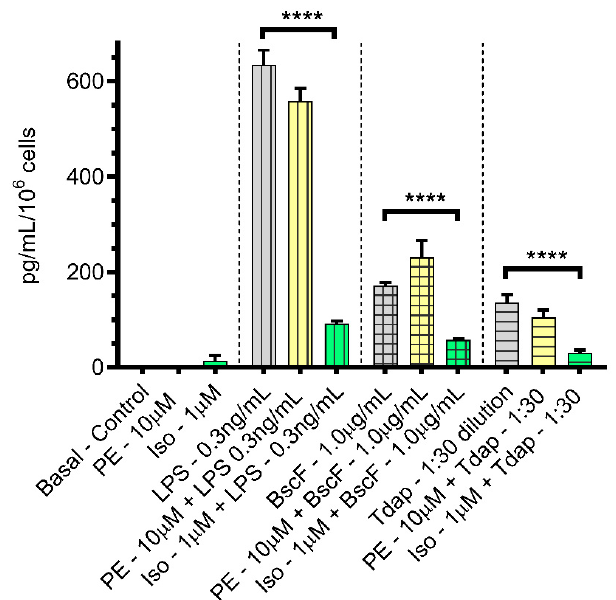
Figure 1. Both PE and ISO attenuated CCL20 expression, upregulated by LPS or the B. pertussis antigens, BscF, and Tdap in THP-1 cells. THP-1 cells in serum-deprived RPMI media treated with PBS, PE alone (10.0 µ M), and ISO alone (1.0 µ M) as control treatments, LPS alone (0.3 ng/mL), BscF alone (1.0 µ g/mL), and Tdap alone (1:30 dilution) as antigen stimulation and LPS + PE (0.3 ng/mL + 10.0 µ M)/LPS + ISO (0.3 ng/mL + 1.0 µ M), BscF + PE (1.0 µ g/mL + 10.0 µ M)/BscF + ISO (1.0 µ g/mL + 1.0 µ M), and Tdap + PE (1:30 dilution +10.0 µ M)/Tdap + ISO (1:30 dilution +1.0 µ M) as agonist-treatment groups. After 24 h incubation, conditioned media from both control and treatment groups were collected, and chemokine levels were quantitated with FMIA. The data presented are the mean and standard error of triplicate assays. Statistically significant changes are indicated by **** p <